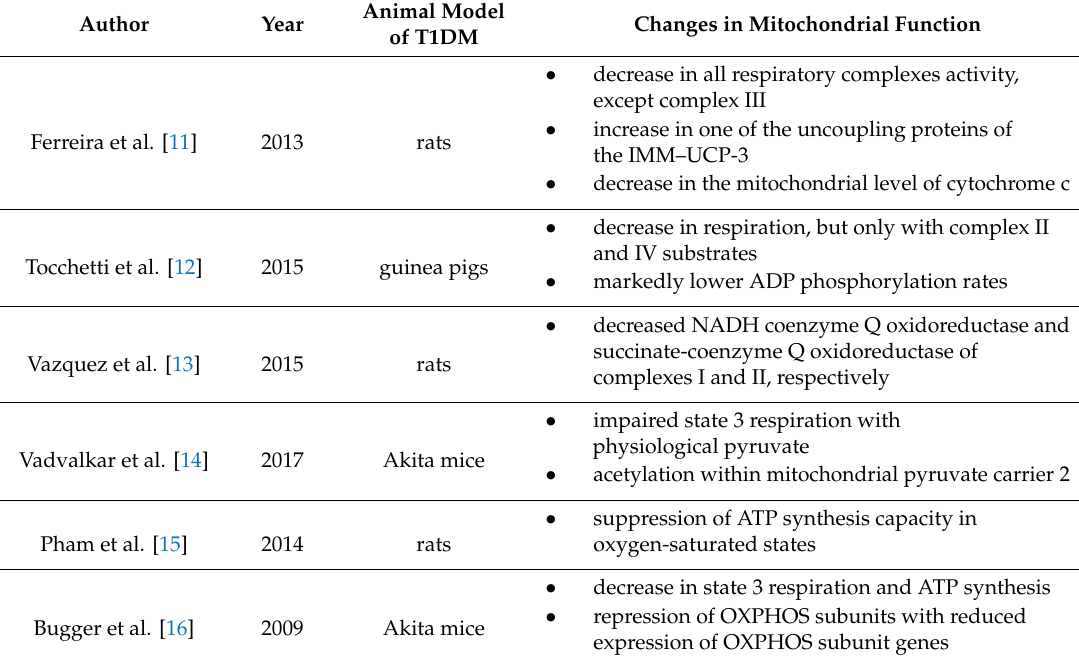
Table 1. Changes in mitochondrial function based on various animal